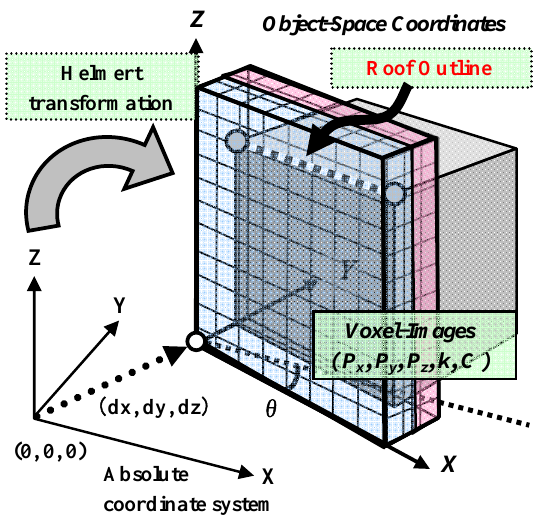
Figure 3. Generation of a Voxel-Image